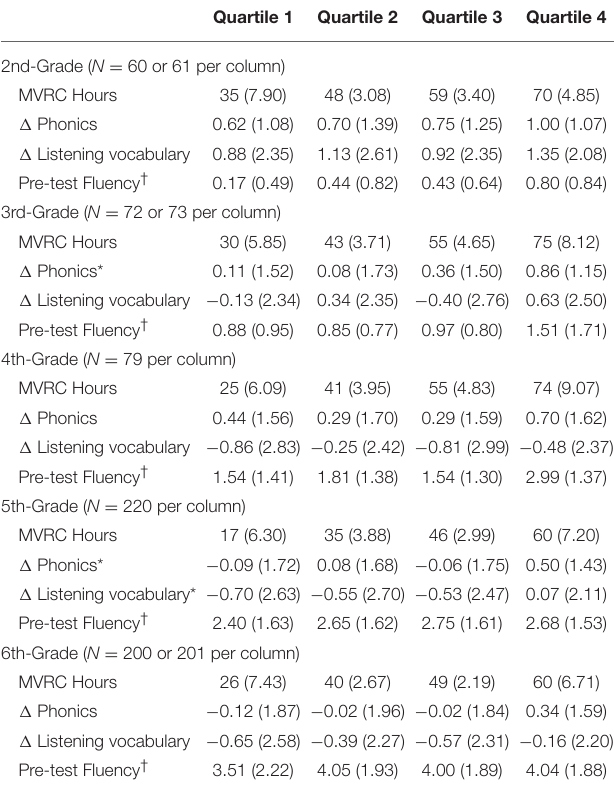
TABLE 3 | District 1 averages separated by grade, quartile, and type of measure. Quartile 1 Quartile 2 Quartile 3 Quartile 4